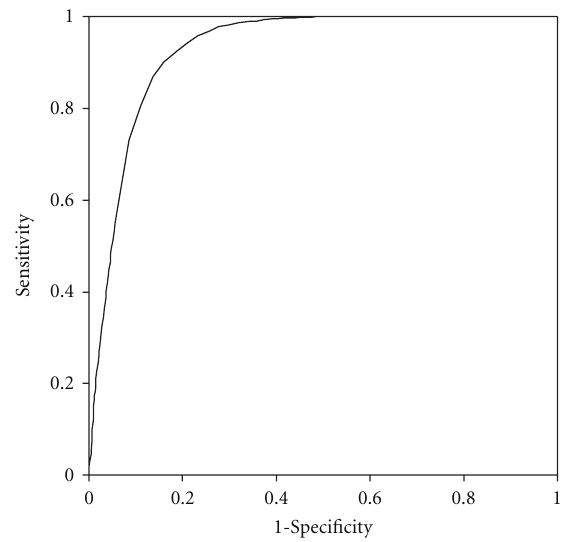
Figure 2: ROC curve analysis of epitopes binding HLA A ∗ 0201.